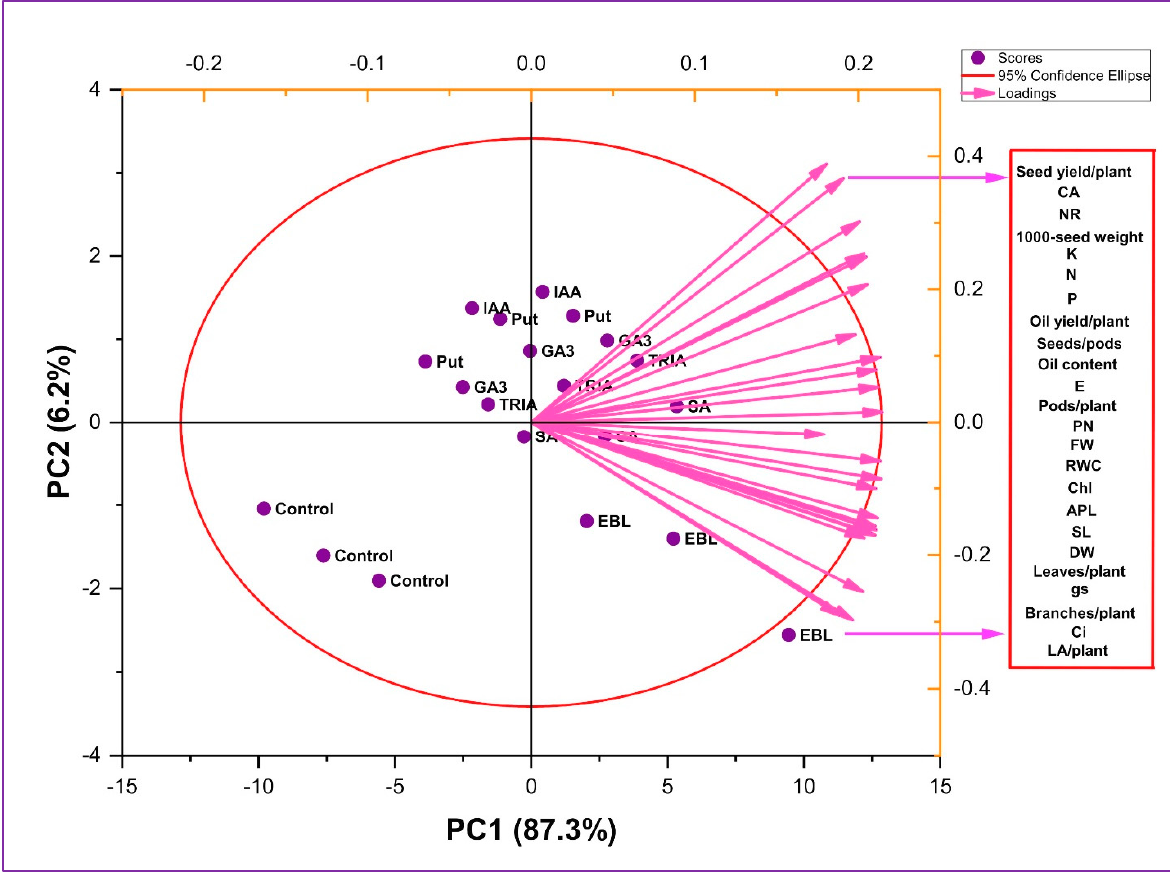
Figure 8. The PCA biplot of PGR treatments and the various parameters studied for the three culti- vars.